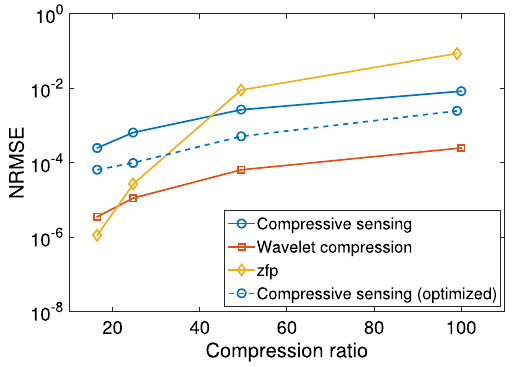
Fig. 15 Plots showing the global NRMSE between the original and reconstructed data fields using different scientific data compression methods as a function of the compression ratio. The solid lines indicate results obtained with a constant compression ratio throughout the subdomains, while the solid line indicate results for CS using the optimal compression ratio obtained by Eq. 24. Results are reported for all 120 field variables of a RCCI simulation at t ¼ 72 where N ¼ 25 ; 600. A wavelet order w ¼ 5 was used in compressed sensing and wavelet